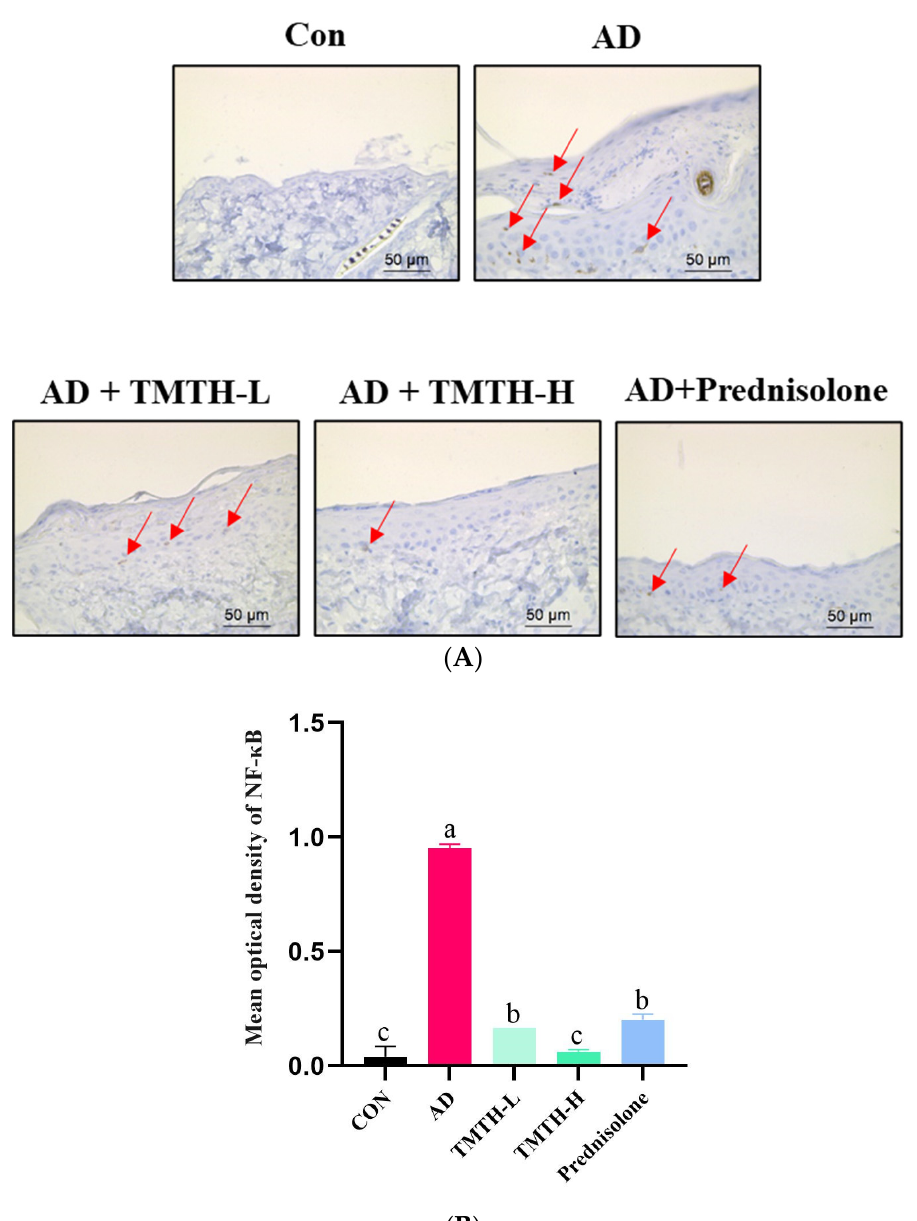
Figure 8. Immunohistochemical analysis of nuclear factor (NF)- κ B expression levels in DNCB-treated AD mice treated with Tenebrio molitor trypsin hydrolysate (TMTH) and prednisolone. (A) NF- κ B expression of dorsal skin tissue of DNCB-induced mice ×400 magnification (50 µm; Scale bar). (B) Mean optical density of NF- κ B expression. ImageJ software was used to quantify the expression level of NF- κ B. After selection of area of interest with positive expression, integrated optical density was calculated in relation to area of sum. CON: control group; AD: DNCB-treated group; TMTH-L: mice challenged with 1% 2,4-dinitrochlorobenzene (DNCB) treated with 1 mg/kg TMTH; TMTH-H; mice challenged with 1% DNCB treated with 10 mg/kg TMTH; Prednisolone: mice challenged with 1% DNCB treated with 3 mg/kg prednisolone.